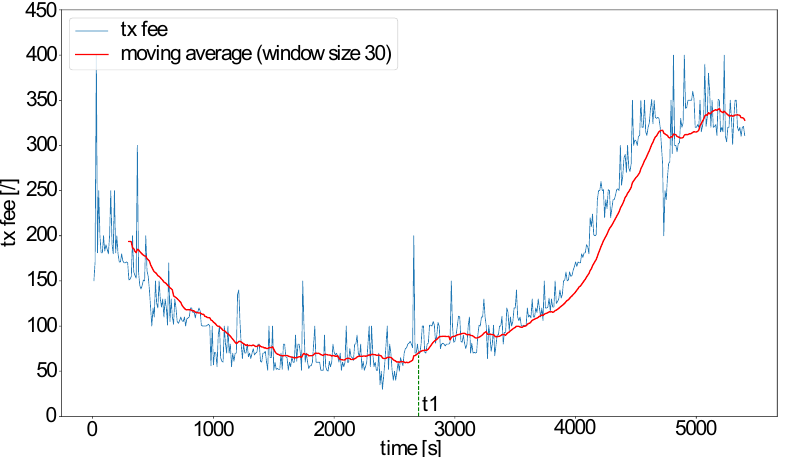
Figure 4. Transaction fee of confirmed transactions over